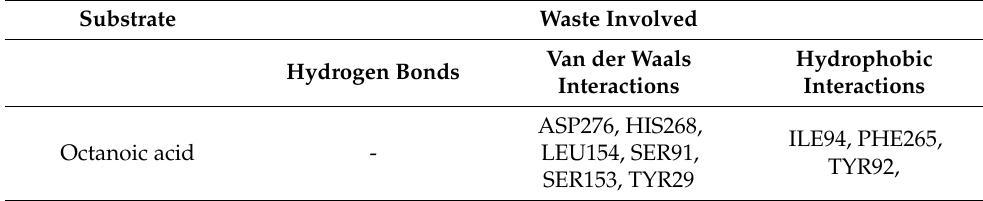
Figure 3. Diagrammatic representation of the interactions between the ligands and the enzyme’s active site. ( a ) Octanoic acid; ( b ) Decanoic acid; ( c ) Dodecanoic acid; ( d ) Tetradecanoic acid; ( e ) Hexadecanoic acid; ( f ) cis-9-octadecanoic acid. Table 5. Interactions of ligands with lipase after